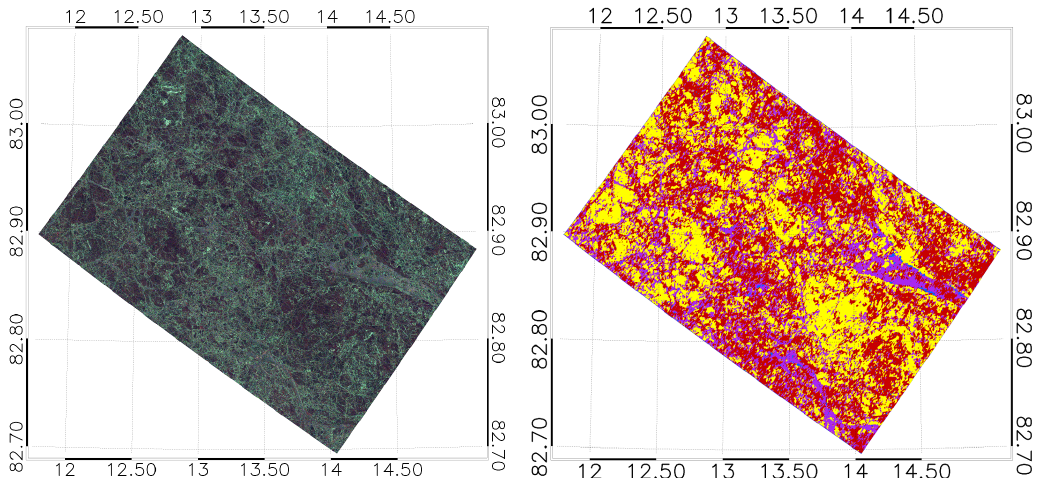
Figure A4. ( Left ) Geocoded Pauli RGB composite (Red: HH-VV Green: HV+VH Blue: HH+VV) of the RS-2 acquisition on 19 April 2015, frame 2; ( Right ) ice classification. Blue: open water/nilas (OW), purple: young ice (YI), yellow: first year ice (SFYI), red: rough first year ice/multi-year ice (RFYMYI).